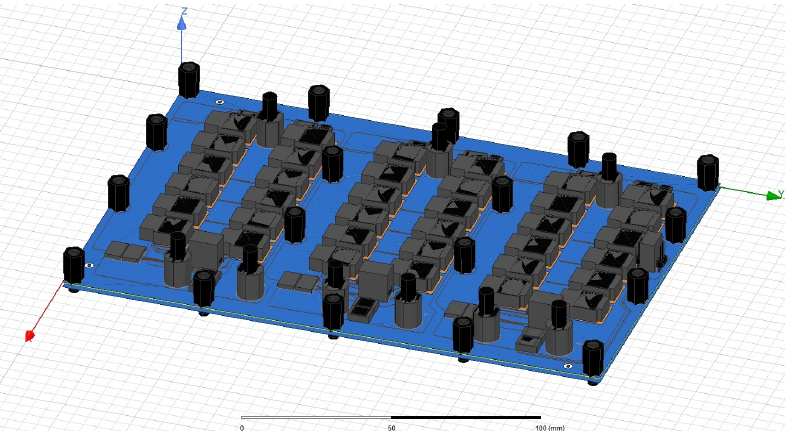
Figure 1. Importing in Q3D Extractor the entire system on which to operate the PCB